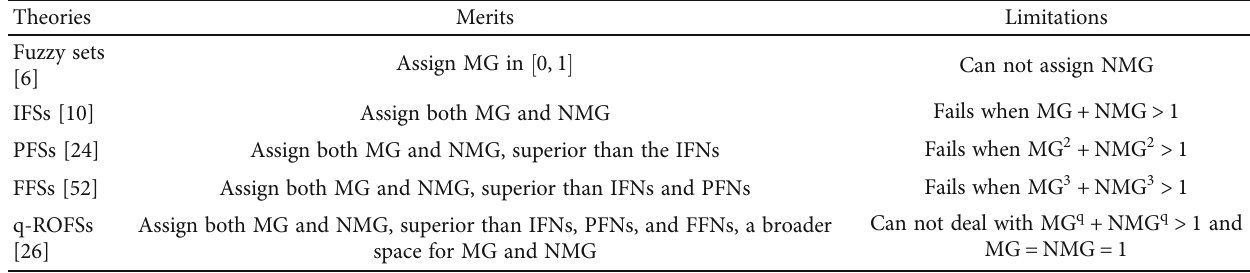
Table 1: Comparative analysis of